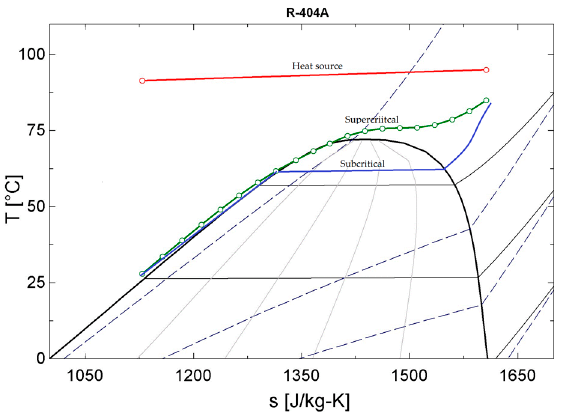
Figure 1. T - s diagram of subcritical and supercritical heat transfer in the heat exchanger in an organic Rankine cycle (ORC).